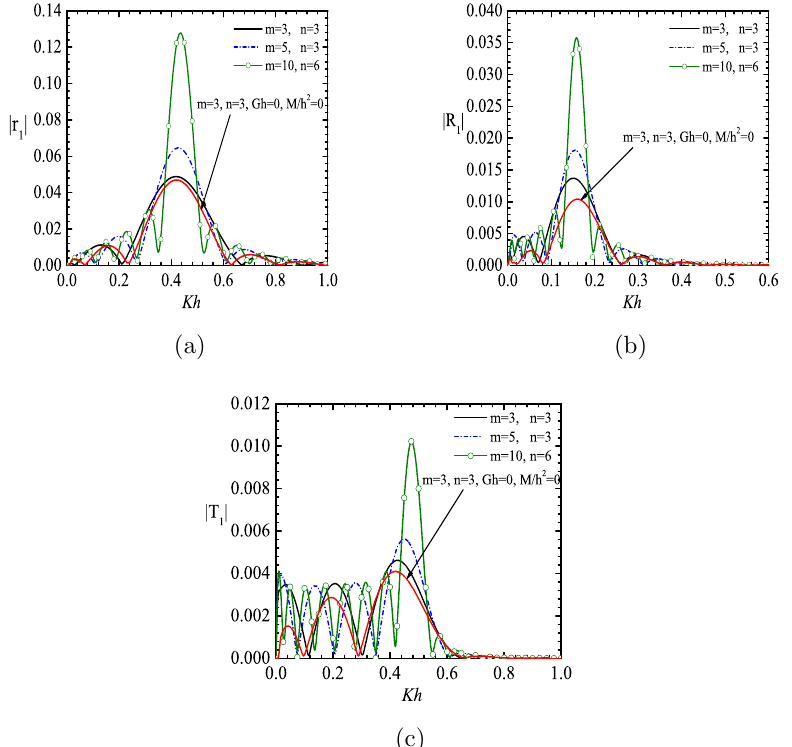
Figure 4. Coefficients due to incident wave of mode λ 1 in (a) | r 1 | ; (b) | R 1 | ; (c) | T 1 | for H/h = 2, a/h = 0 . 1, γh = 1, ρ = 0 . 5, M/h 2 = 0 . 2, Gh = 0 .